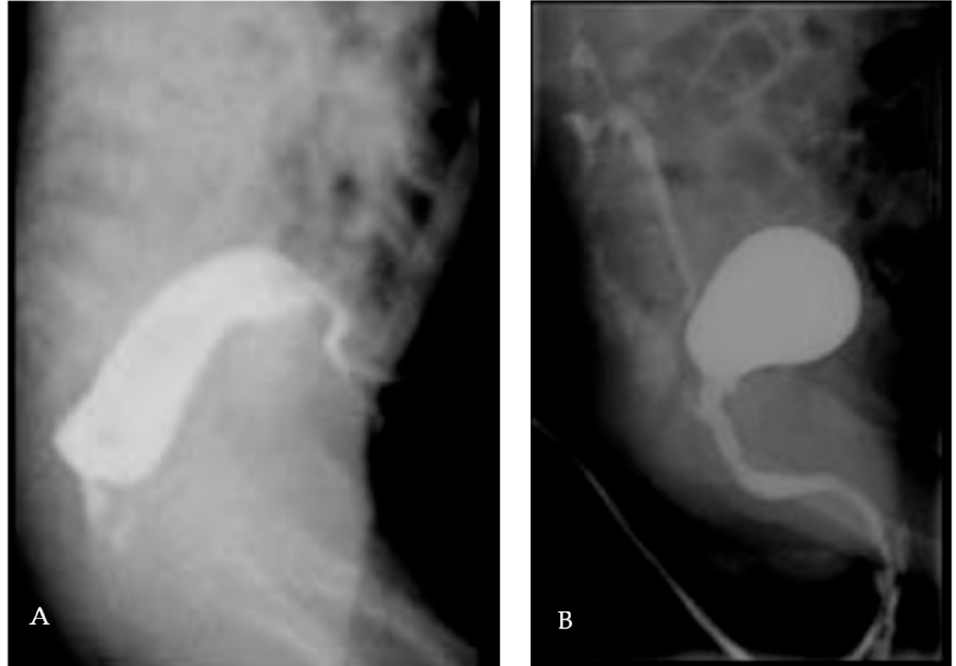
Figure 7. ( A ): Colon contrast imaging with recto-prostatic fistula. ( B ): MCUG with recto-prostatic fistula and vesicoureteral reflux grade III right.